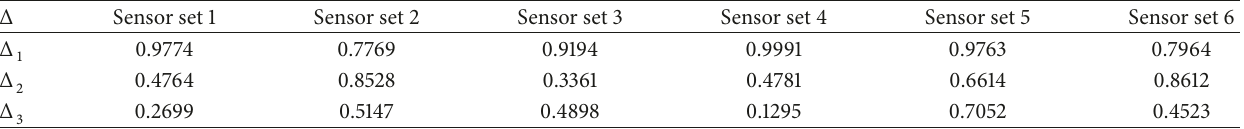
Table 3: The ratio Δ for different principal components without measurement